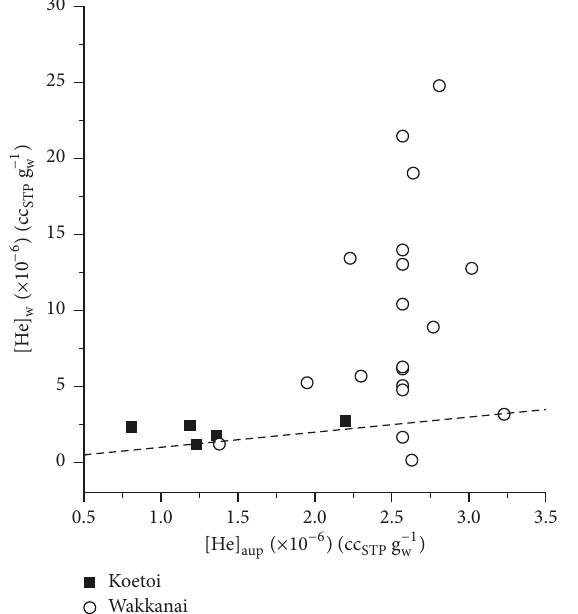
Figure 13: The relationships between 𝛿 D and Cl − concentration in Figure 12: Comparison of [ He ] and [ He ] : [ He ] is defined as w aup w the porewater in the Koetoi and Wakkanai the He concentration without the effect of mantle He, as calculated by (10); [ He ] is defined as the He concentration obtained by the aup multiplication of the accumulation rate of 4 He by radiogenic effects (calculated in Section 5.2.2) and time (1.0 million years).